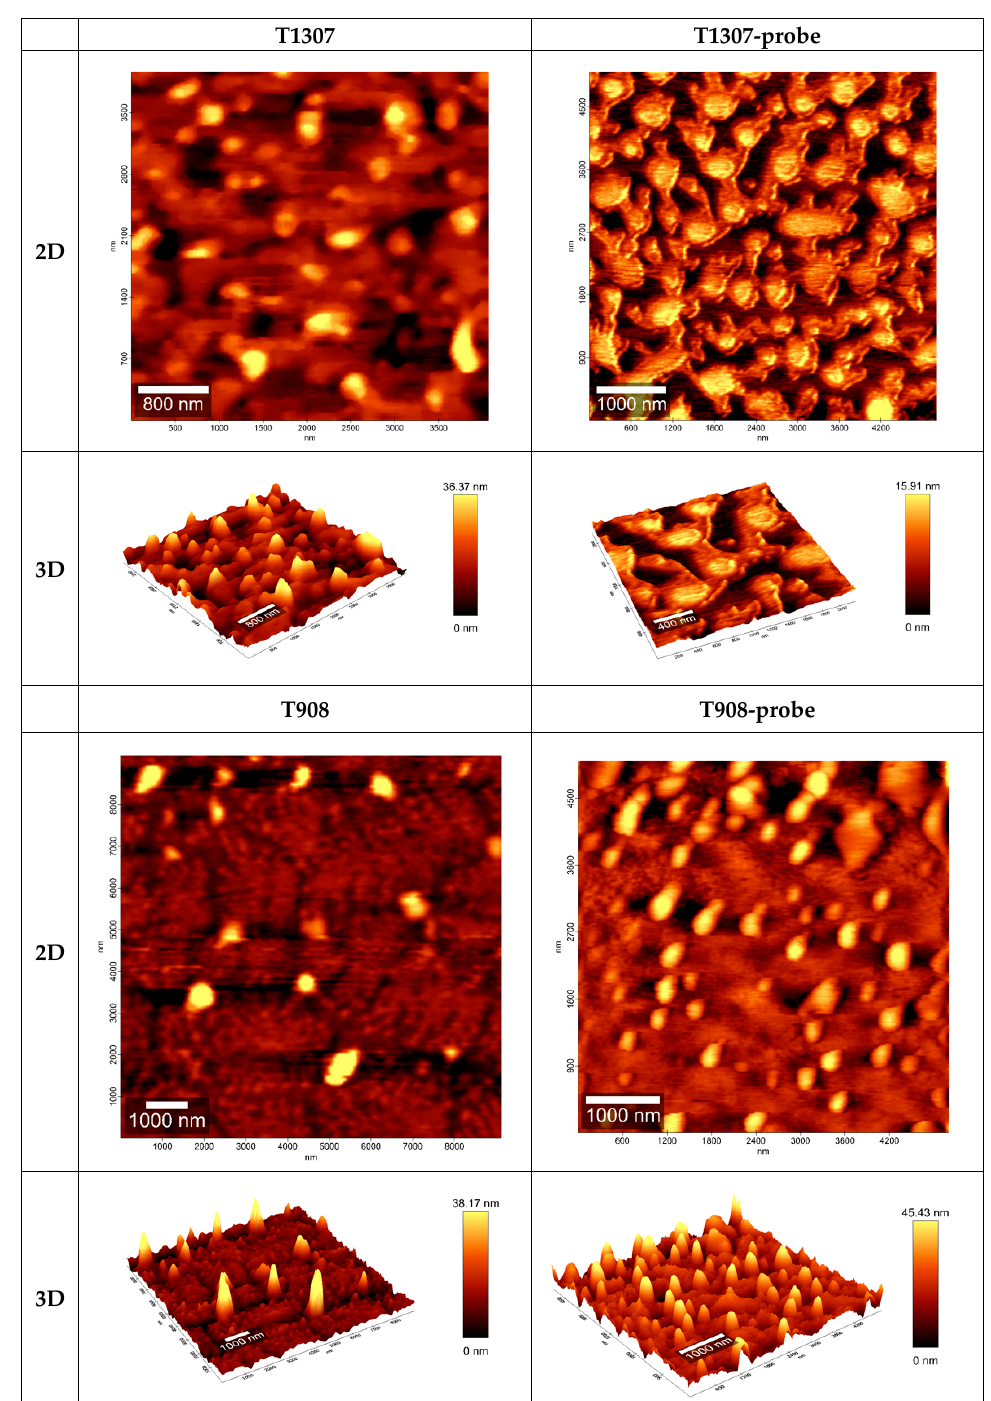
Figure 4. AFM images for topology in nm two-dimenstional (2D) and (three-dimensional (3D) representation for free-probe, F127, F127-probe, T1307, T1307-probe, T908, and T908-probe. Notice the off-surface arms on F127-probe PMs (2D, image on the upper right), which strongly suggest the probe on the surface.